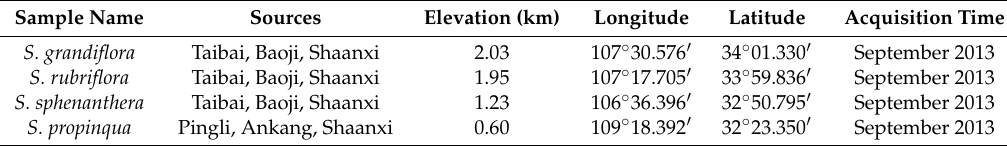
Table 1. A summary of the tested samples.